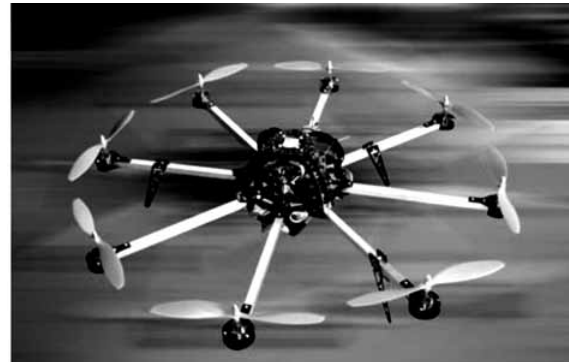
Fig. 5. Colombian UAV